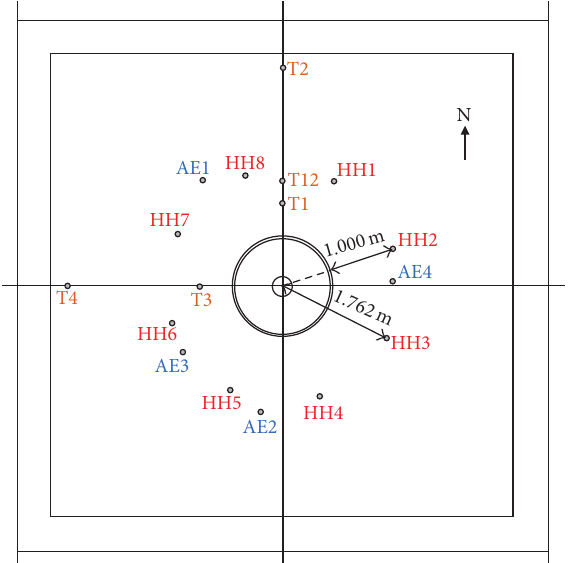
Figure3:Theresultingheaterpattern(HH)andpreexistingtemper- ature monitoring holes (T) and acoustic emission monitoring holes (AE). The inner 7 m × 7 m square shown is the levelling concrete slab and the outer 8 m × 8m square is the insulation layer.